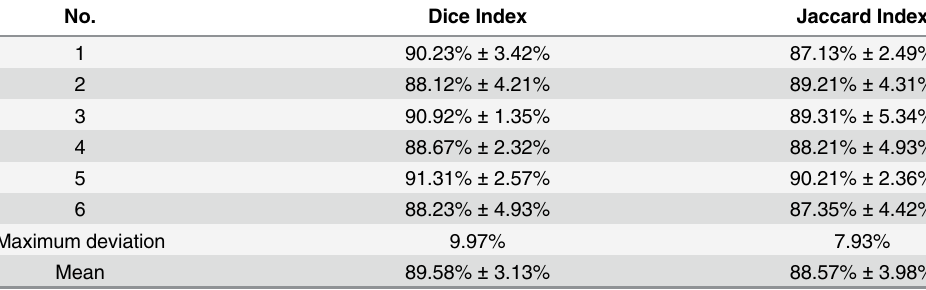
Table 2. The results of the Dice index and Jaccard Index.